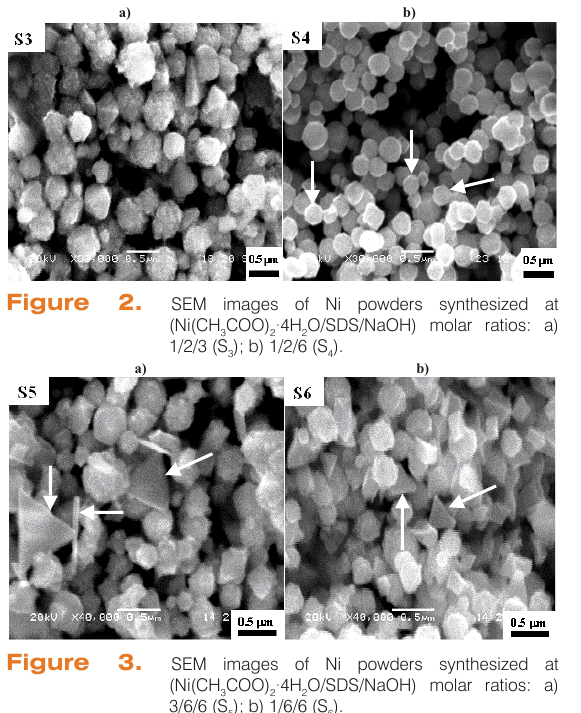
Figure 3. SEM images of Ni powders synthesized at (Ni(CH